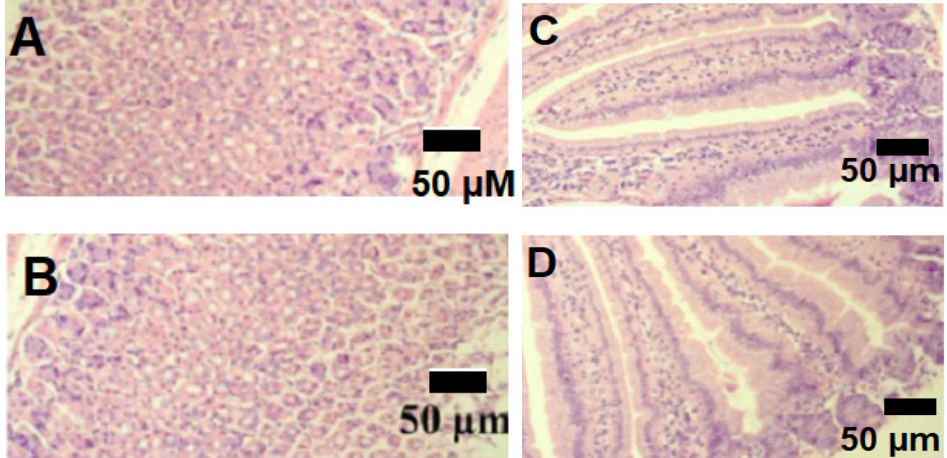
Figure 8. Histological analysis of rat stomach sections ( A , B ) and small intestine sections ( C , D ). The control groups ( A , C ) were given water and the treated groups ( B , D ) were given Lavandula pedunculata (LP) aqueous extract every day for four weeks. The figure shows the absence of any cellular modifications after the chronic administration of LP while compared to the